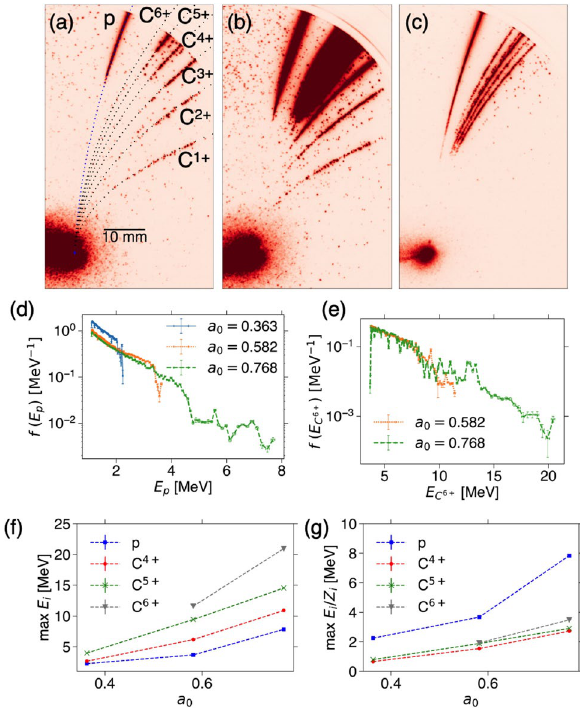
Figure 2. High contrast defocused shots: energy dependence. TPS images from three successive 4L-LSG target shots with increasing laser energies with ( a ) 4.40 J measured before the compression chamber, corresponding intensity I = 2.78 × 10 17 W cm − 2 , where the 32% enclosed energy is taken into account 22 , and the normalized intensity a 0 = 0.363 , ( b ) 11.3 J, 7.15 × 10 17 W cm − 2 , a 0 = 0.582 , and ( c ) 19.7 J, 1.25 × 10 18 Wc m − 2 , a 0 = 0.768 . ( d , e ) The energy distribution functions of protons and C 6 + after subtracting the background signals as discussed in the Supplementary information. ( f , g ) The maximum energies of protons and carbons (C 4 + –C 6 + ), and the maximum energies divided by the charge state Z ,